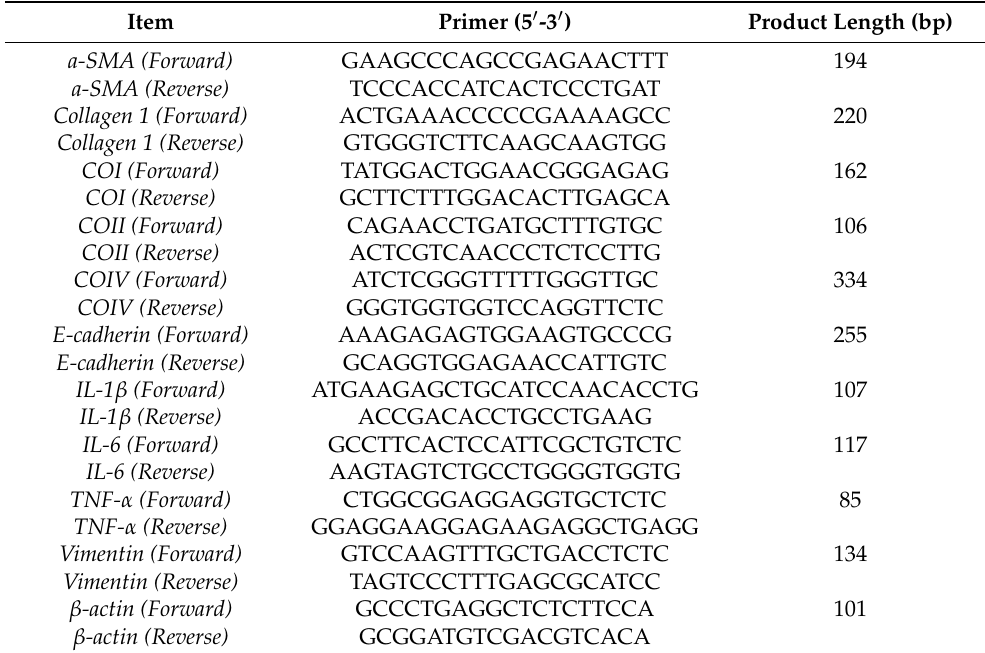
Table 5. The primer